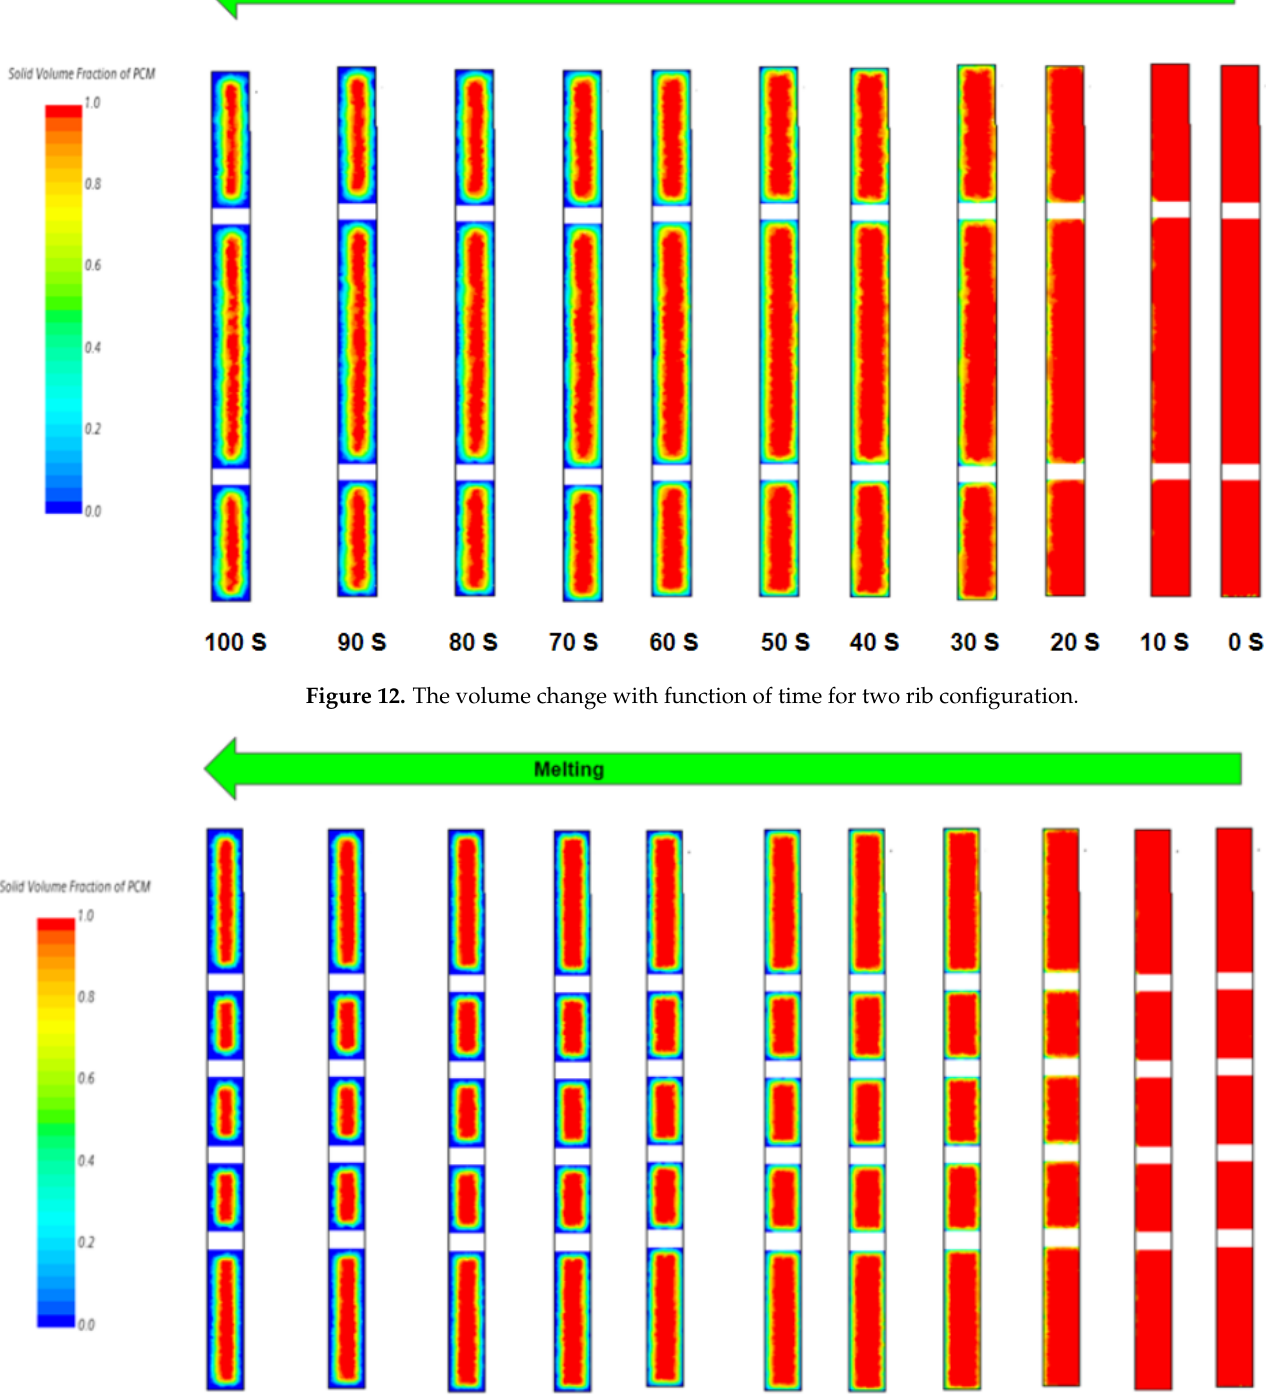
Figure 13. The volume change with function of time for four rib configuration.